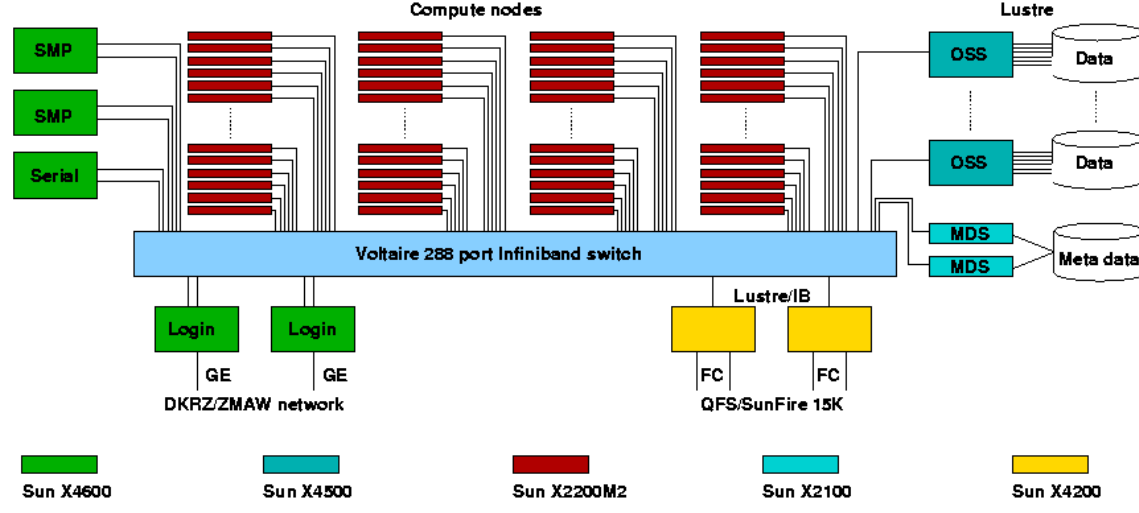
Fig. 2. A schematic of the used cluster hardware also known as “Tornado” of the Deutsche Klima Rechenzentrum (from the Tornado Wiki Hardware